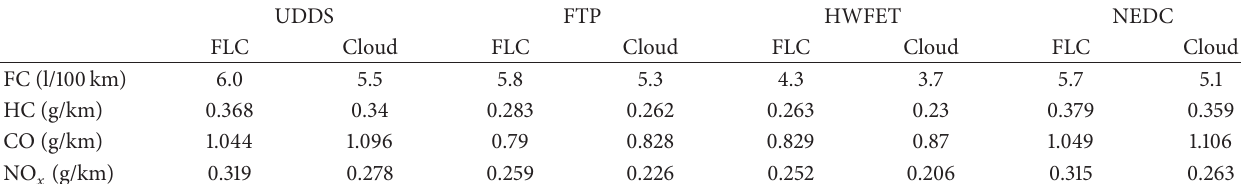
Table 1: Comparison of fuel consumption and emissions for four cycles.